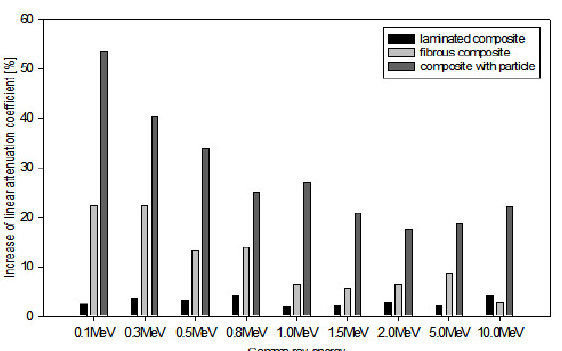
Figure 15. Rate of increase of linear attenuation coefficient caused by structural change of PE/lead composite.